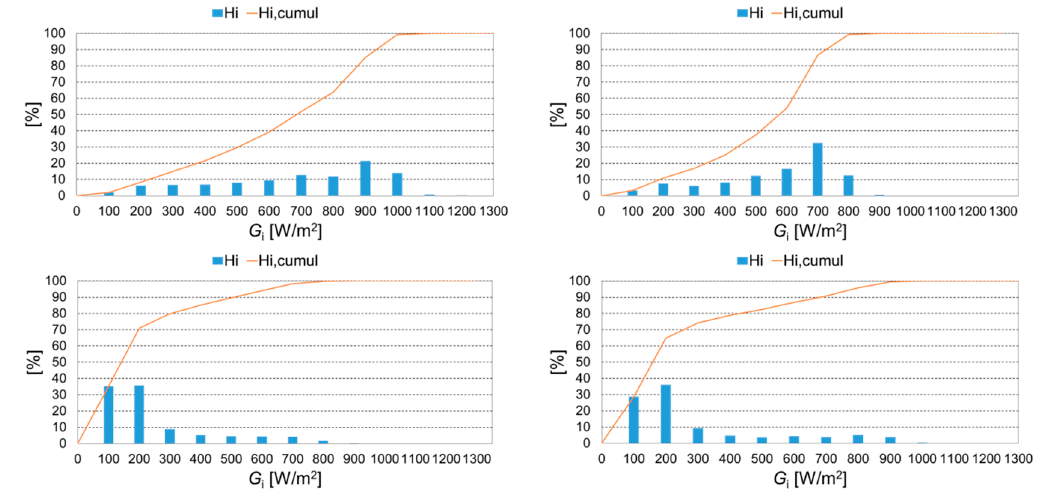
Figure 11. Percent and accumulated percent of H i ( H i,cumul , in %) in different ranges of G i during March 2016 for PVGCS #3 ( top left ), March 2016 for PVGCS #4 ( top right ), August 2017 for PVGCS #3 ( bottom left ), and August 2017 for PVGCS #4 ( bottom right ).